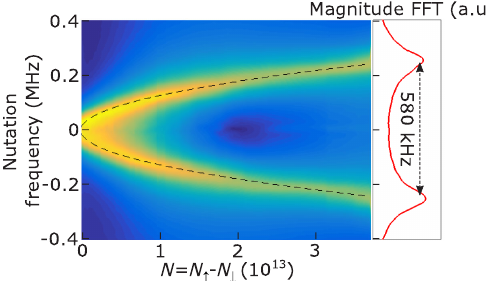
FIG. 5. Fourier transform (plotted as magnitude) of the donor spin-ensemble free-induction decay as a function of the number of unpaired spins in the ensemble ( N ). The black dashed line ffiffiffiffi p N shows a g dependence of the pseudospin-cavity exchange rate as expected from the Tavis-Cummings model in the large N limit. This gives a single-spin coupling of g ¼ 48 mHz for a uniformly coupled ensemble. The side plot shows a vertical slice at N ¼ 3 . 6 × 10 13 cm − 3 for the maximum ensemble coupling that ffiffiffiffi p ¼ 580 N was achieved ( 2 g